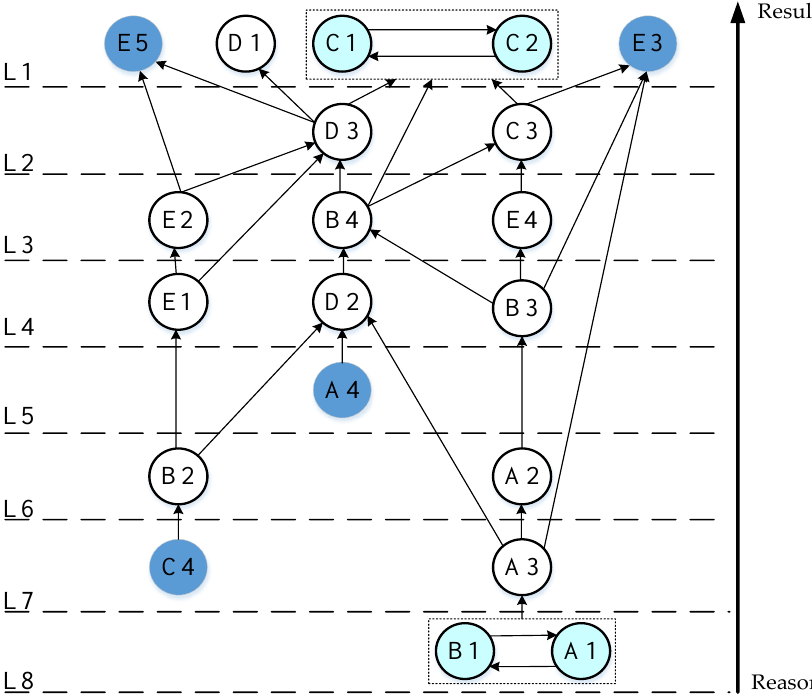
Figure 5. Hierarchical diagram of UP-type result-first directed topology.